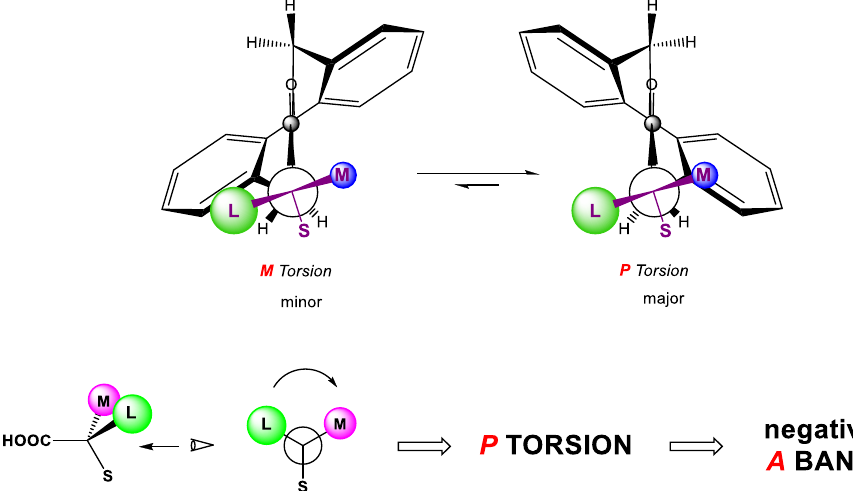
Figure 2. Top: schematic representation of the conformational equilibrium in 2-alkyl-substituted biphenyl amides. Bottom: mnemonic scheme relating the absolute configuration and the sign of the A band in the ECD spectrum of biphenylamides. L = largest group, M = medium size group, S = smallest group. Reprinted with permission from [19]. Copyright 2006, American Chemical Society.